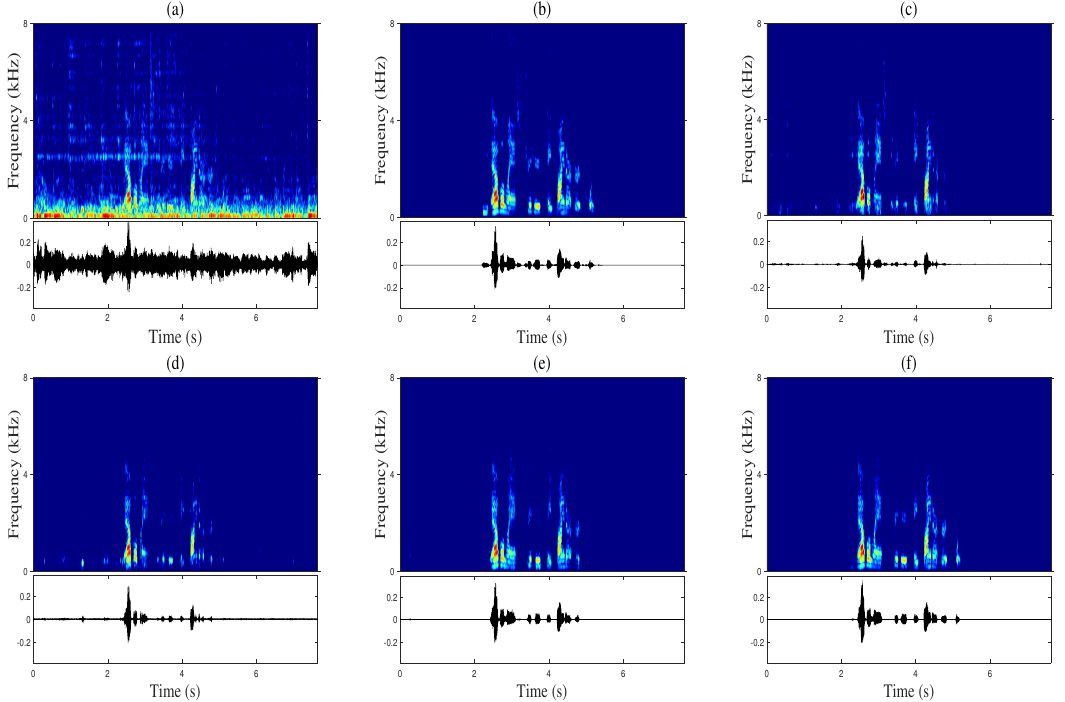
Figure 8. Spectrogram (top) and waveform (bottom) comparison in babble noise and the music-type far-end (at an SER of -4 dB and an SNR of 6 dB): ( a ) microphone input signal, ( b ) near-end speech, ( c ) stacked DNN [11], ( d ) CRN [12], ( e ) single-channel version of Multi-TALK, and ( f ) the proposed Multi-TALK (4